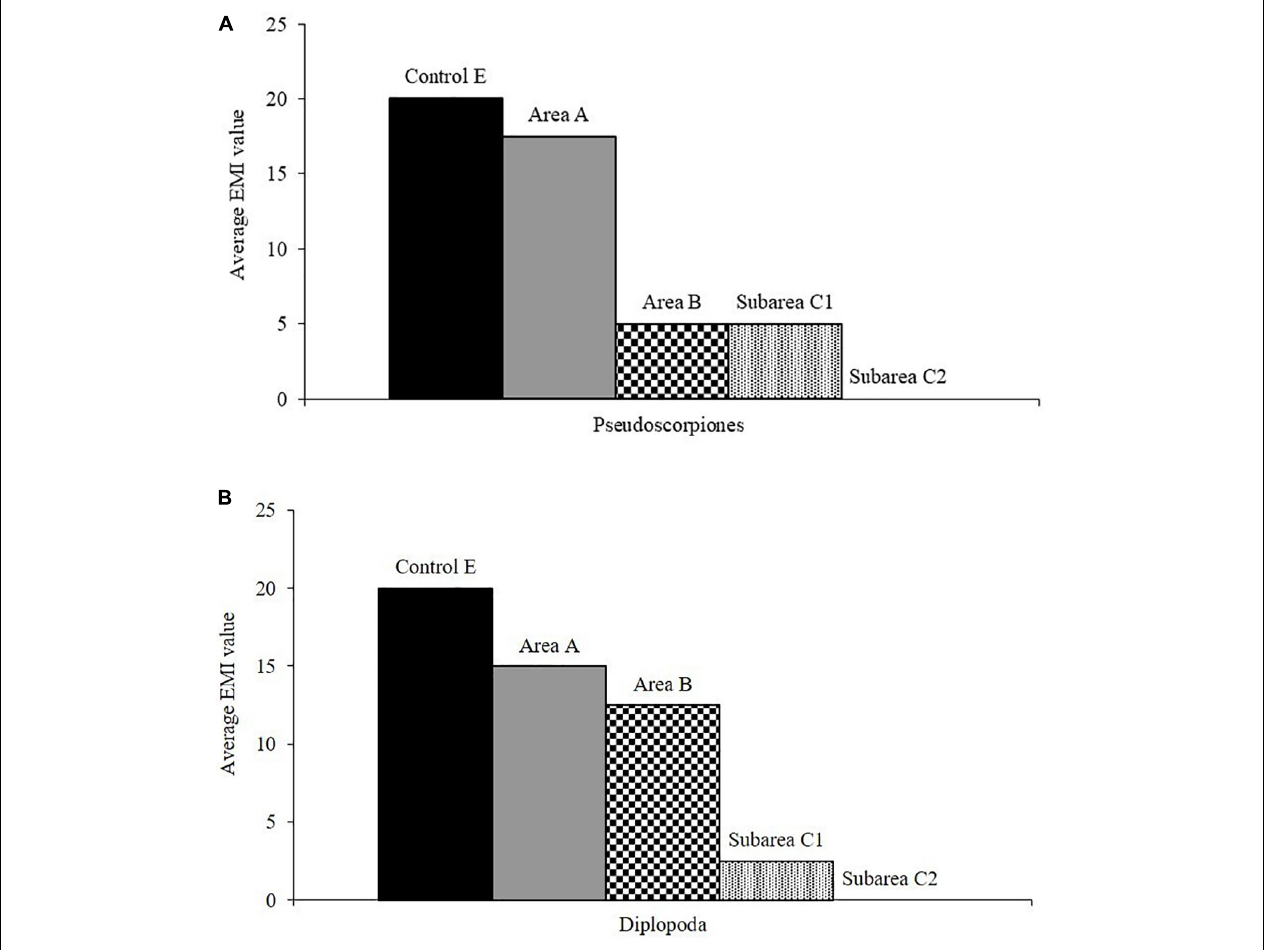
FIGURE 7 | Average EMI values of taxonomic groups ( A = Pseudoscorpiones; B = Diplopoda) with major contribution to dissimilarity for plot never burned (E) and areas burned (SIMPER procedure; cut off ≈ 70% EMI